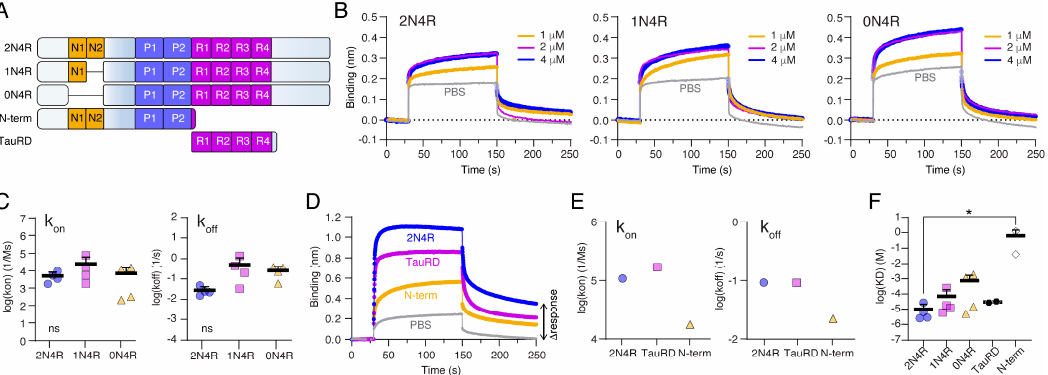
Figure 2. The Tau repeat domain mediates the binding to Nup98-FG. ( A ) Domain structure of Tau 2N4R, 1N4R, and 0N4R isoforms as well as the N-terminal (N-term; aa 1–257) and the Tau repeat domain (TauRD, aa 244–372) constructs. ( B ) Representative BLI measurements of Tau isoforms 2N4R, 1N4R, and 0N4R measured at 1, 2, and 4 µ M binding to an immobilized Nup98-FG layer. Reference measurements for PBS were recorded for each construct individually. ( C ) Association constants (k on ) and dissociation constants (k off ) for Tau isoforms binding to Nup98-FG. Data shown as the mean + SD from four replicates. One-way ANOVA with Tukey’s post-test. ( D ) Representative BLI measurements of 2N4R, TauRD, and N-term binding to Nup98-FG. The PBS reference is shown as well. An increase in the Nup98-FG layer height ( ∆ response) results from incomplete detachment of Tau during the dissociation phase. ( E ) Association (k on ) and dissociation values (k off ) from ( D ). ( F ) Summary of equilibrium constants (K D ) for 2N4R, 1N4R, 0N4R, TauRD, and N-terminal Tau variants. Data are shown as the mean + SD. One-way ANOVA, Dunnett’s test for multiple comparison, 2N4R versus N-term: * p = 0.0480 (* p <